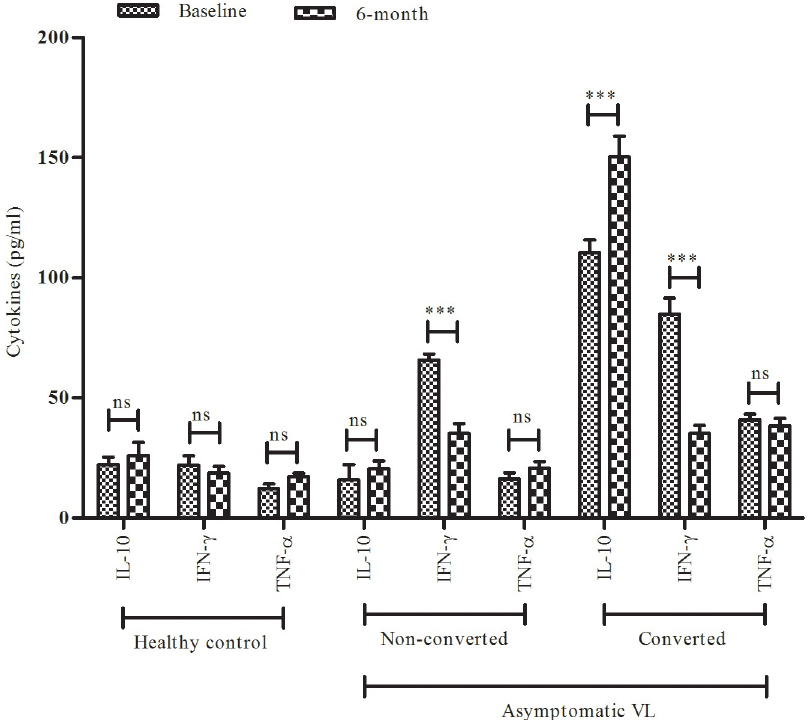
Fig 3. The relationship between cytokine production (IL-10, IFN- γ and TNF- α ) and positivity in RT-PCR indicating subclinical infection and during the development of symptomatic visceral leishmaniasis (VL) in 10 asymptomatic residents of an endemic area of Bihar. Healthy subject (n = 10), asymptomatic VL (non-converted (n = 32) and converted into VL (n = 10)).Data were represented as mean ± SD, P � 0.05 were considered as significant. � P � 0.05, �� P � 0.01, ��� P � 0.001, ns